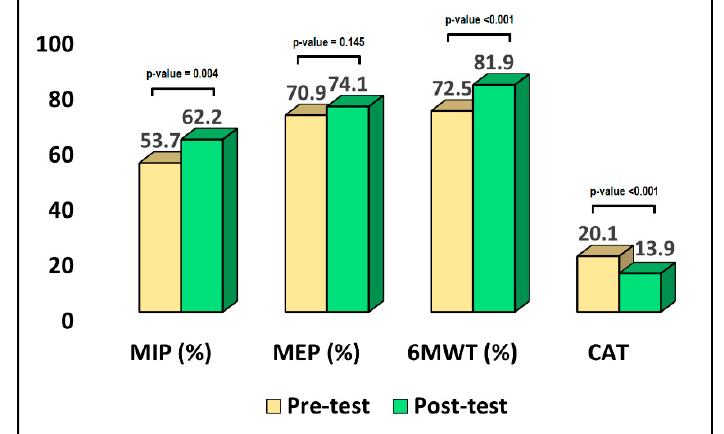
Figure 2. Comparison of pre-test and post-test results in the online setting.